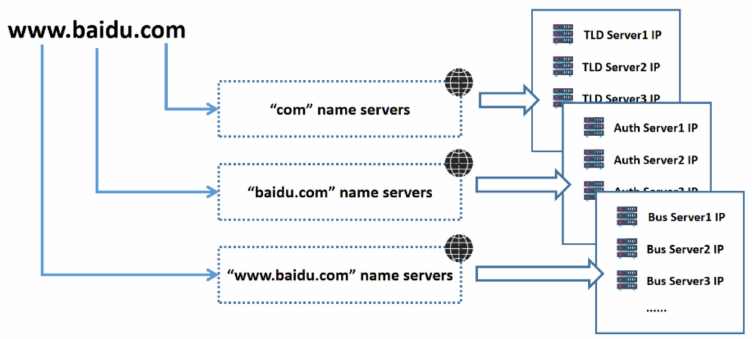
Figure 5. Running example of tracking a domain name server.